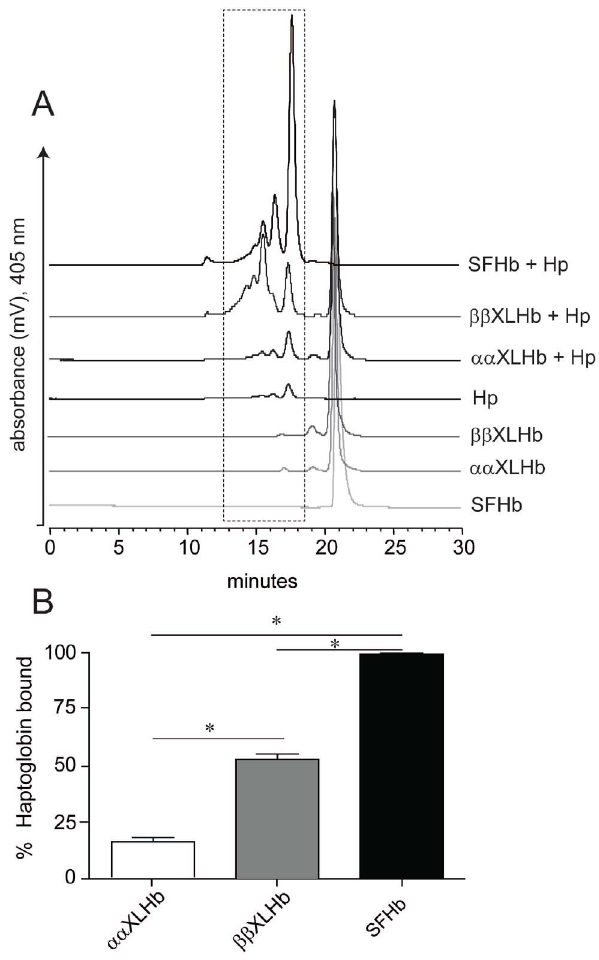
Figure 1. Analytical size exclusion chromatography of Hbs with or without Hp. A. Representative chromatograms of Hb, aa XLHb, and bb XLHb in the presence or absence of Hp. The absorbance was monitored at 405 nm for heme, and the peaks appearing between the elution time 13 and 19 minutes are Hb and Hp complexes. B. The percentage of Hp bound with Hb was determined and compared among aa XLHb, bb XLHb, and Hb based on baseline normalized area under curve for peaks within the boxed region of the eluting profiles (from Panel A). Statistical analysis was performed using a One-way analysis of variance with a Bonferroni’s Multiple comparison test to evaluate between group differences. Data are represented as mean areas + / 2 sem, significance was set at p , 0.05. All analysis were performed using GraphPad Prism software.